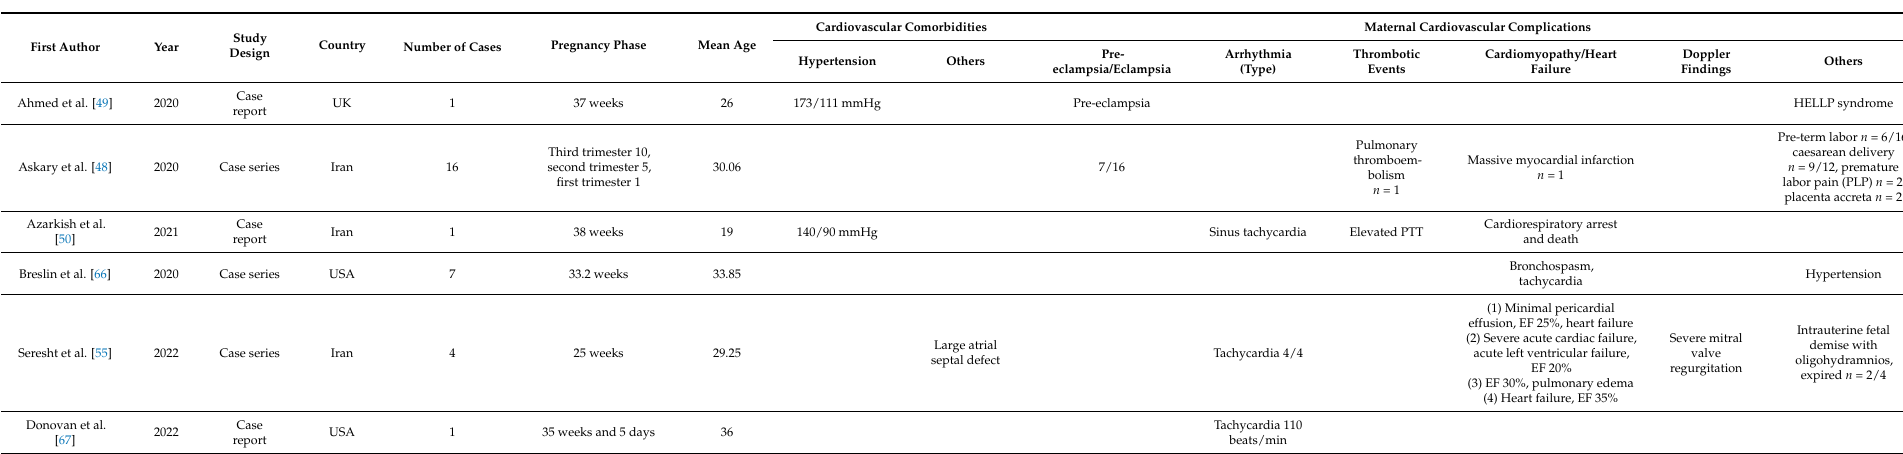
Table 3. Characteristics and maternal outcomes of the included case report/case series